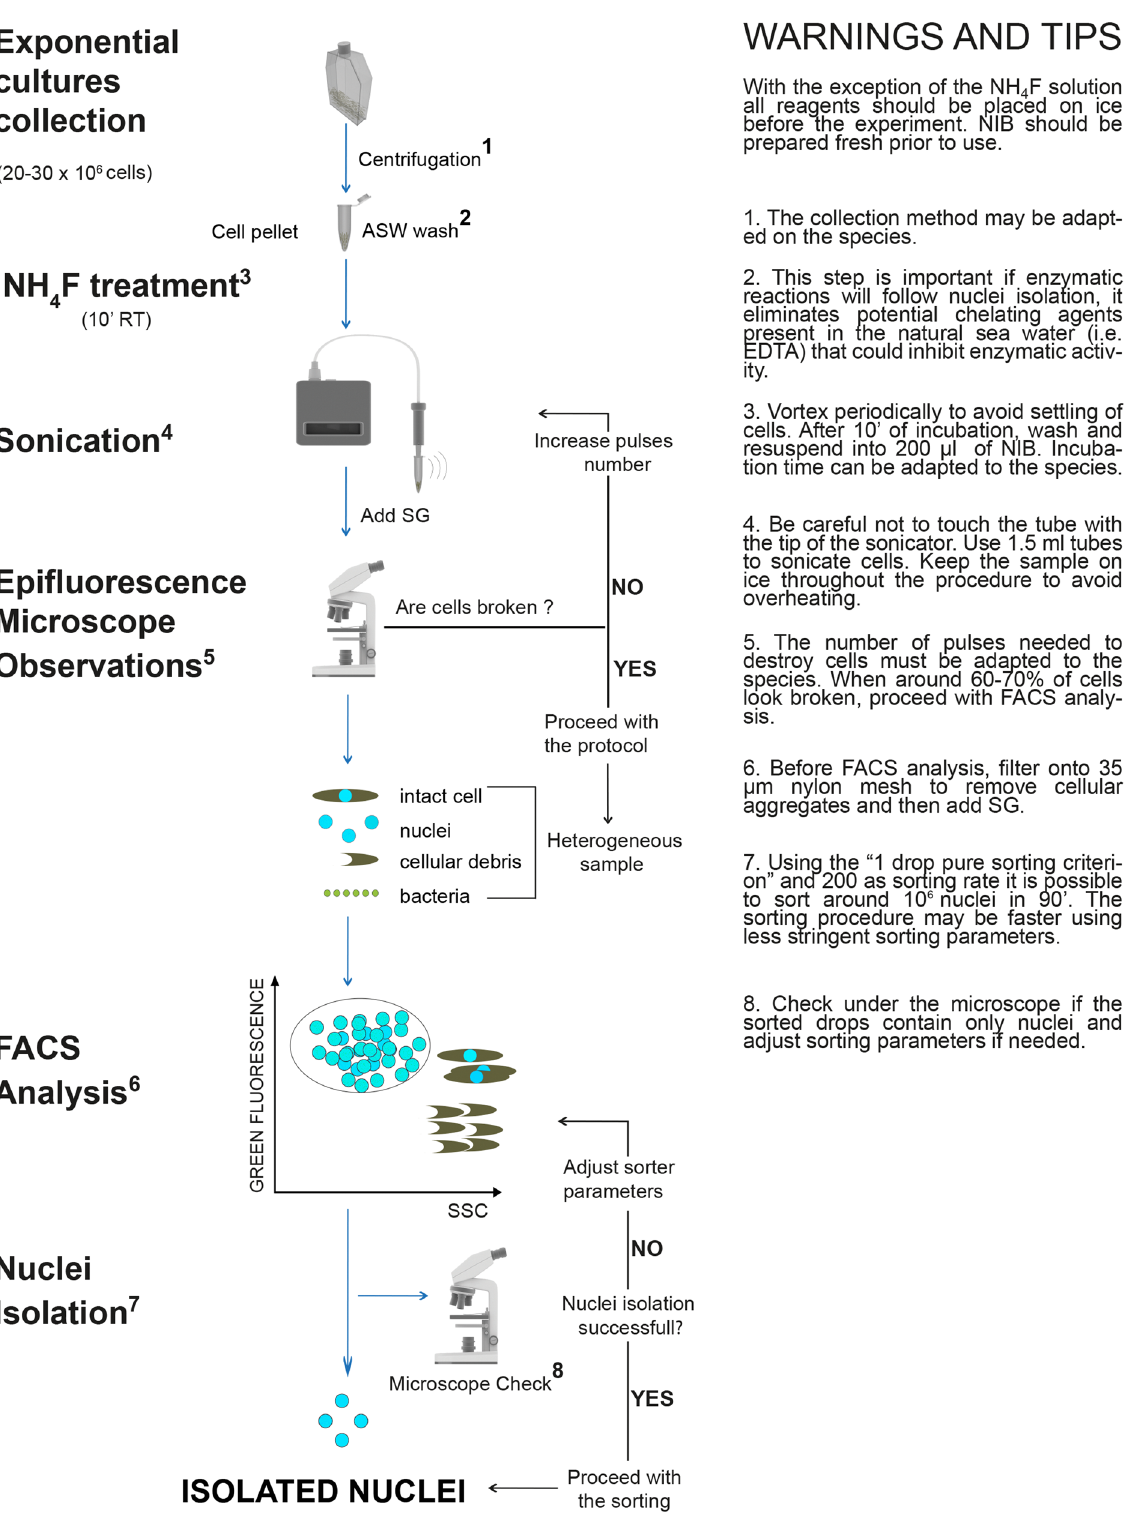
Figure 5. Intact nuclei isolation from diatom cells: the experimental workflow. Step by step protocol and useful warnings and tips to isolate intact nuclei from diatom cells. Main steps are indicated on the left: diatoms cells are harvested via centrifugation; NH 4 F treatment is performed to weaken diatom cell wall; sonication is applied to destroy frustules allowing nuclei extraction which is verified using epifluorescence microscopy; nuclei are sorted by FACS from a mixed sample containing also cellular debris and, in some cases, bacteria, obtaining a clean preparation of isolated nuclei. ASW (Artificial Sea Water), RT (Room Temperature), SG (SYBR Green I), NIB (Nuclei Isolation Buffer), FACS (Fluorescence Activated Cell Sorting), SSC (Side-Scatter). Images used for the figure were adapted from “Library of Science and Medical Illustrations CC BY-NC-SA